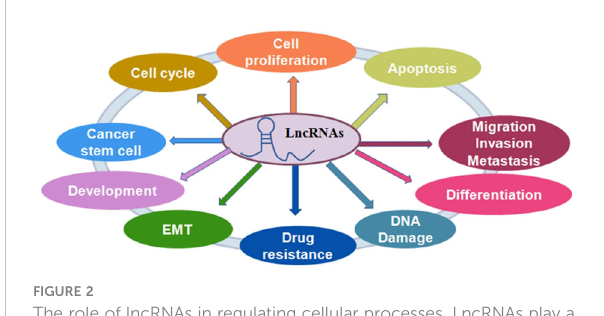
FIGURE 2 The role of lncRNAs in regulating cellular processes. LncRNAs play a critical role in the regulation of cell proliferation, cell apoptotic death, cell cycle, cell migration and invasion, epithelial- mesenchymal transition (EMT), cancer stem cells, DNA damage and drug resistance in cancer